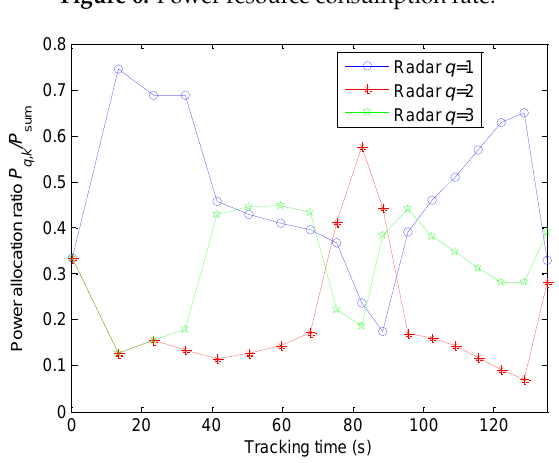
Figure 7. Power allocation ratio.